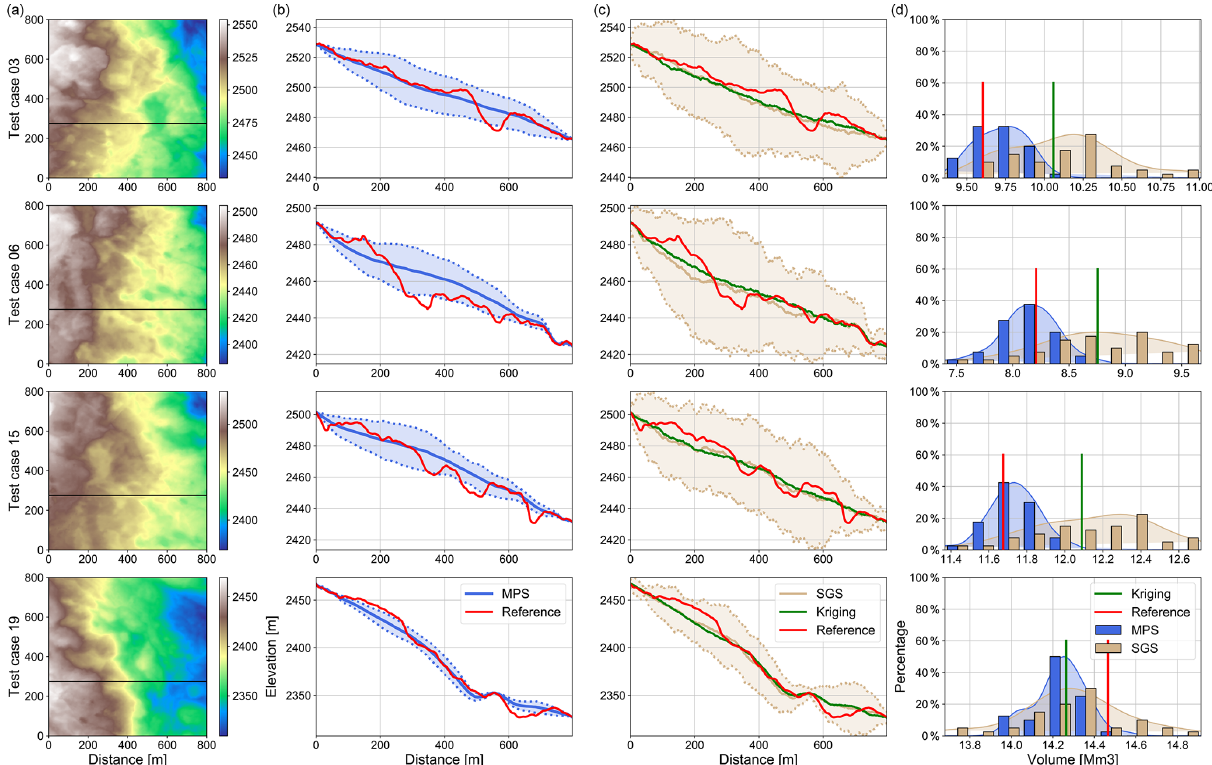
Figure 6. Synthetic test results. Panel (a) displays the reference DEM in a plan view, with the black line showing the location of the cross sections. Panel (b) presents the distribution of the cross section simulated with the MPS method (parameter set 3). Panel (c) presents the distribution of the cross section simulated with the SGS methods (parameter set 1). Panel (d) presents the different volume distribution of the methods against the reference one in red.